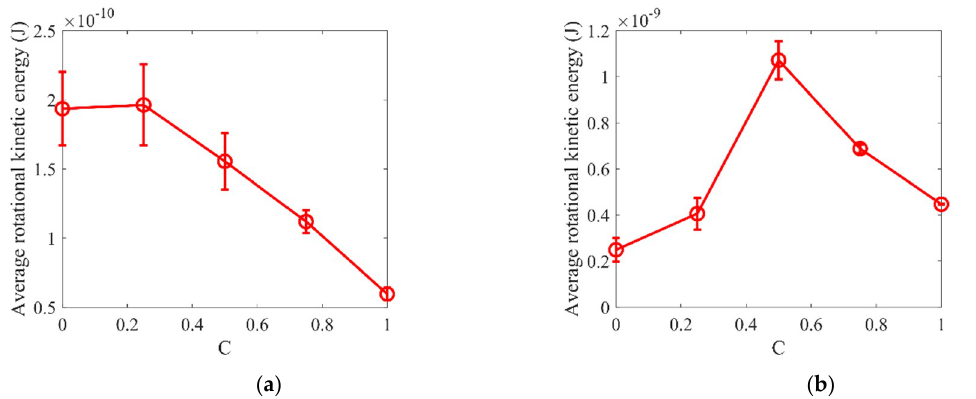
Figure 14. Average rotational kinetic energy of particles as a function of rods fraction C for the binary mixtures of ( a ) AR = 0.3 and 6, ν = 0.5 and ( b ) AR = 0.15 and 6, ν = 0.55. An error bar represents the standard deviation of particle rotational kinetic energies from the average value at the steady flow state.